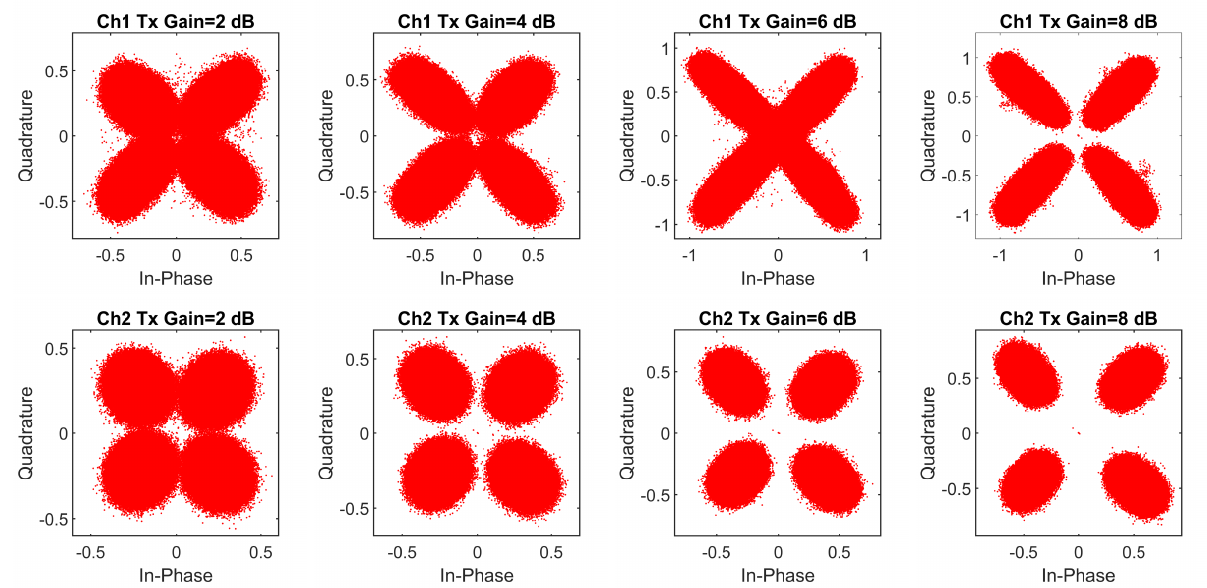
Figure 4. Channel 1 and channel 2 QPSK constellation diagram at 5.6 GHz in a mode-stirred metal enclosure. AGC gain = 60 dB, Rx gain = 0 dB, and Tx gain varied from 2 dB to 8 dB with the step of 2